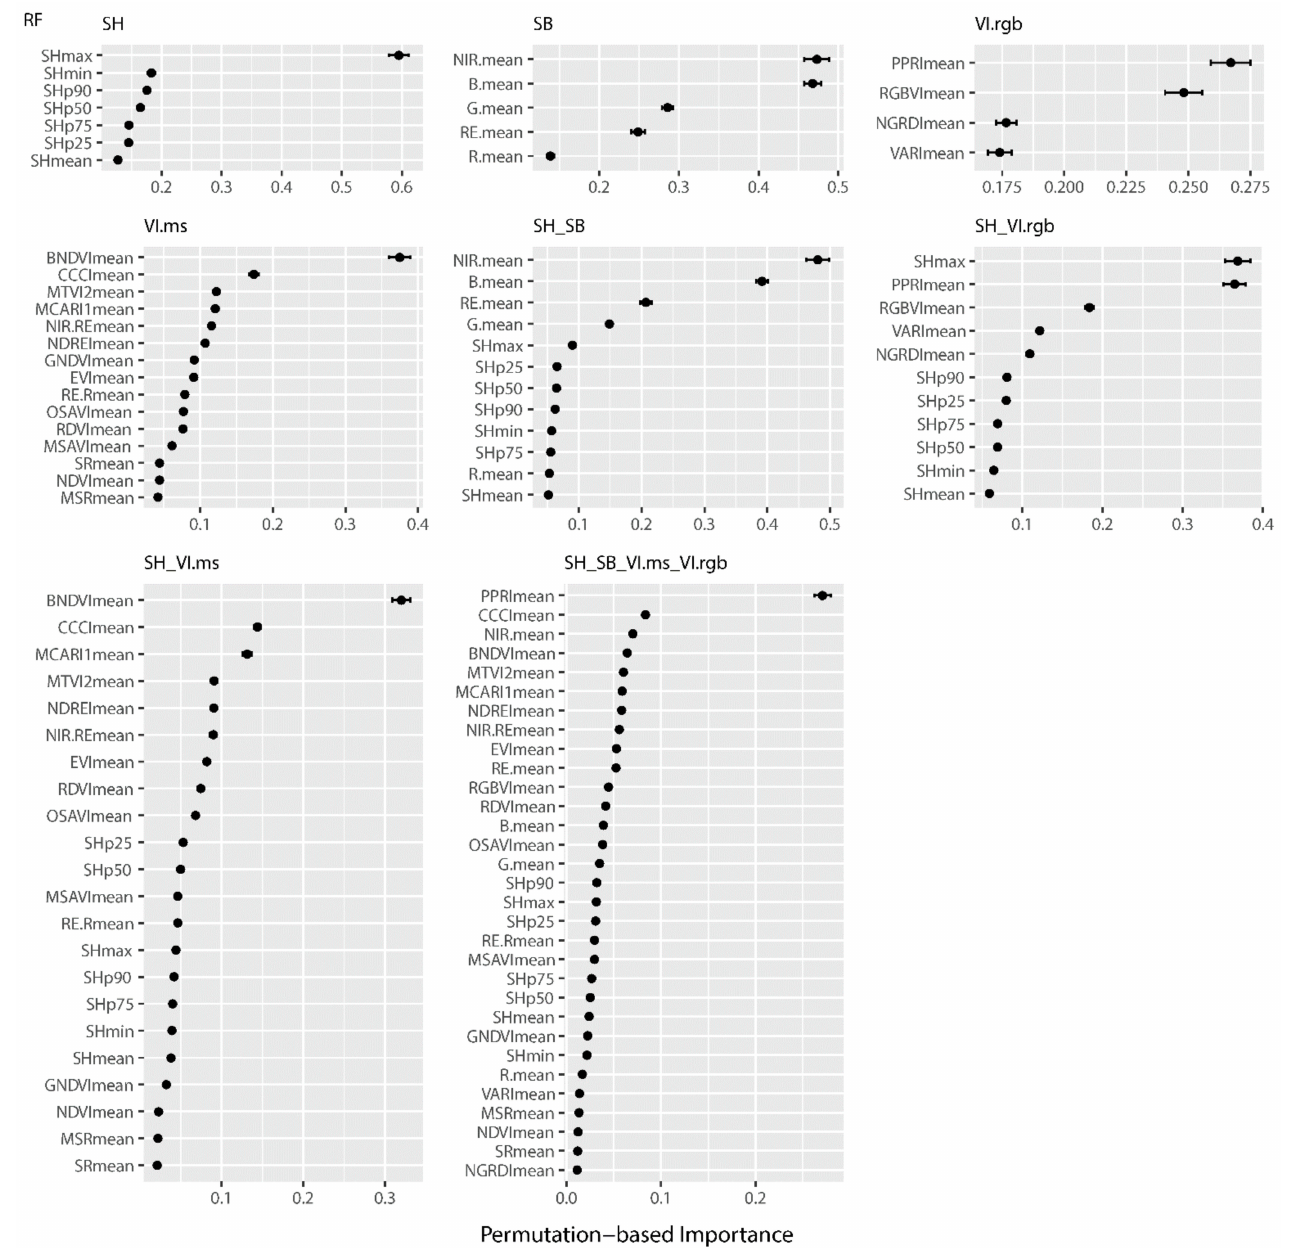
Figure A5. VIP of N% estimation with